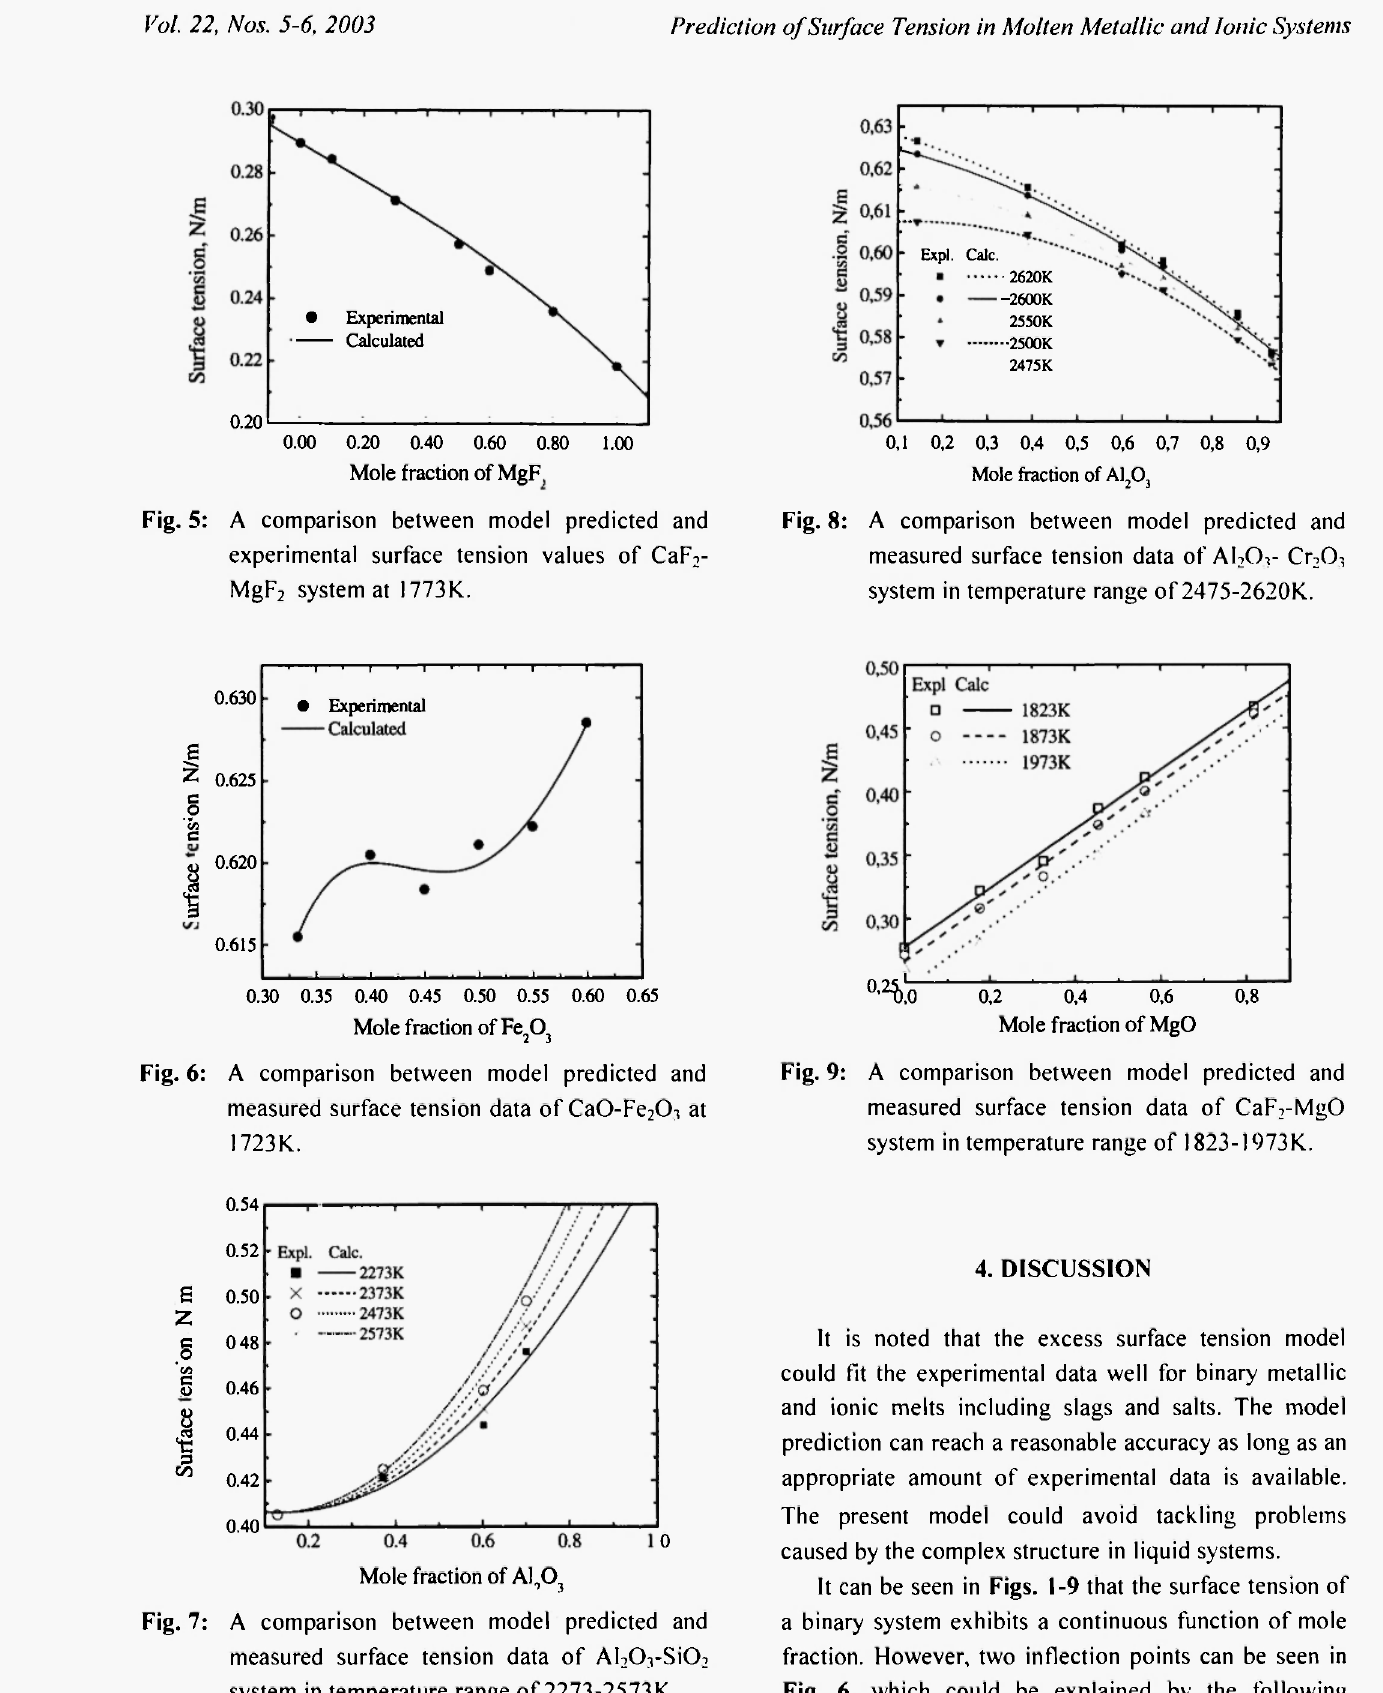
Fig. 7: A comparison between model predicted and measured surface tension data of A I 2 0 r S i 0 2 system in temperature range of